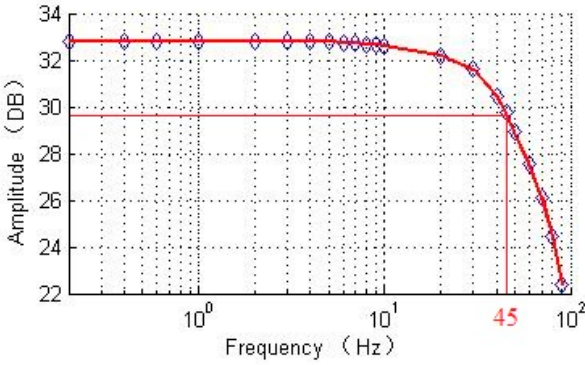
Figure 21. Tested bandwidth of DRG experimental board.